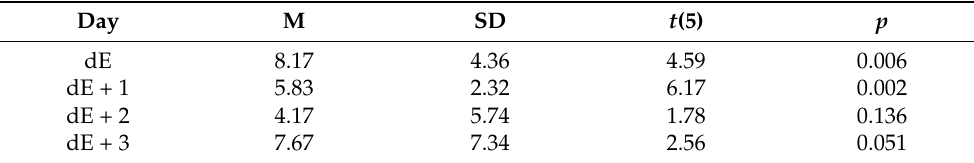
Table 4. Means and standard deviations of intolerance reactions to dairy products of Group 2 ( n = 6).